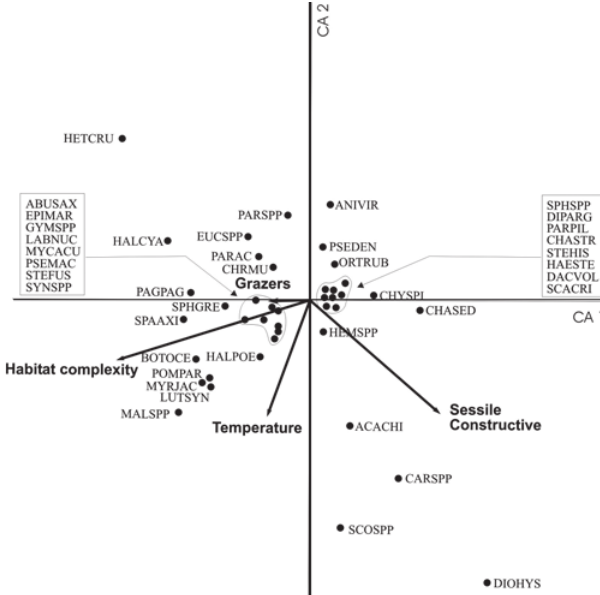
Fig. 5. Canonical Correspondence Analysis (CCA) of species and the correlated variables that most probably explain spe- cies distribution in the canonical